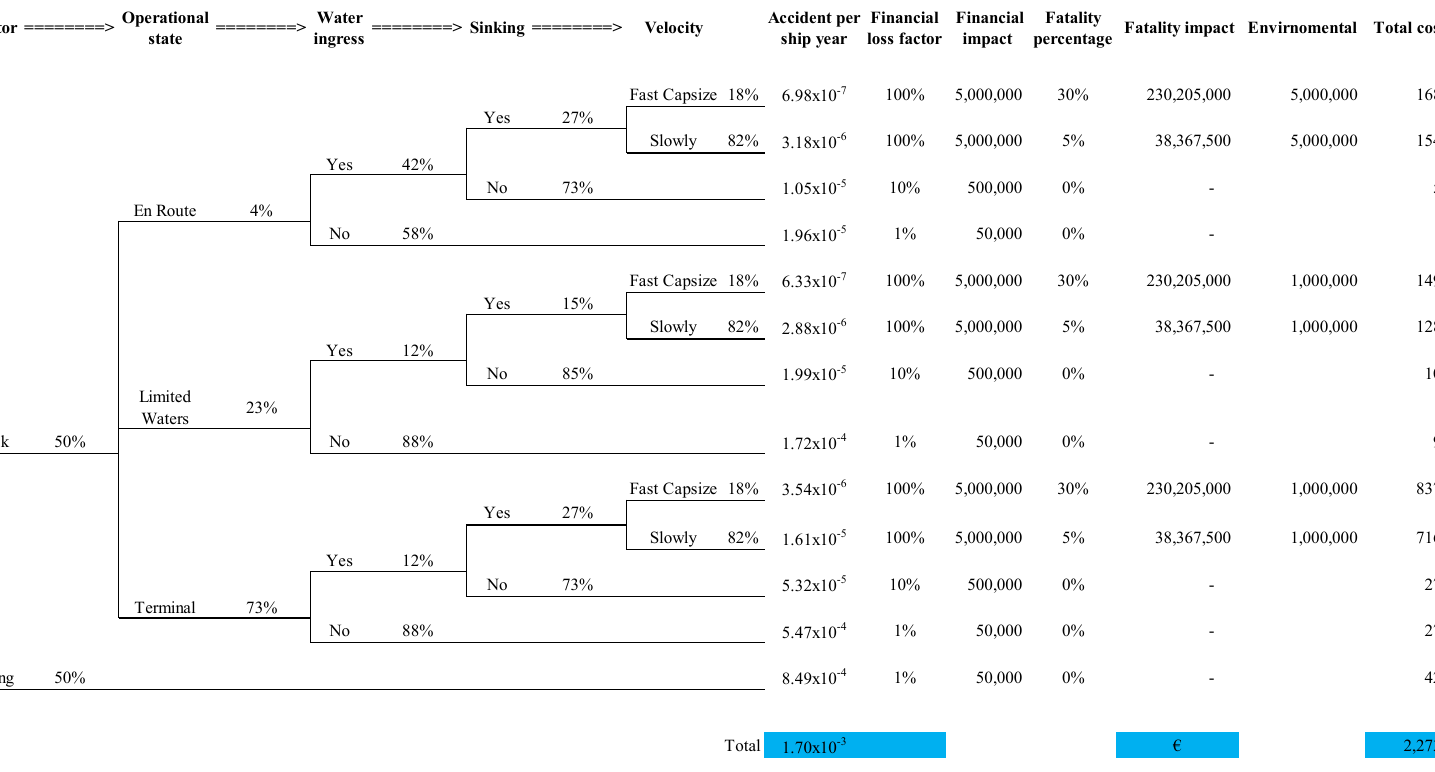
Figure 16. Event tree analysis of a collision for the ferry in this study.